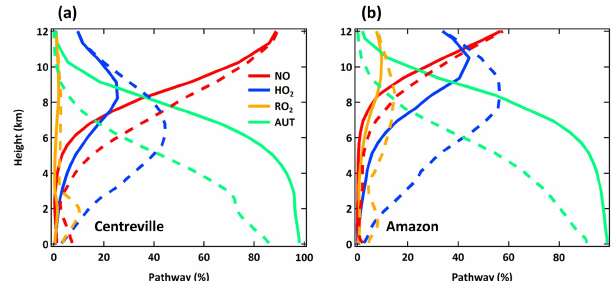
Figure 3. Annual averaged vertical profiles of four dominant reac- tion pathways of MT-bRO 2 at Centreville, AL, USA, and over the Amazon near Manaus from the LowProd_Photo (solid lines) and LowProd_Photo_kauto_Slow (dashed lines) simulations. Reaction with NO 3 contributes less than 1%; thus, it is not shown